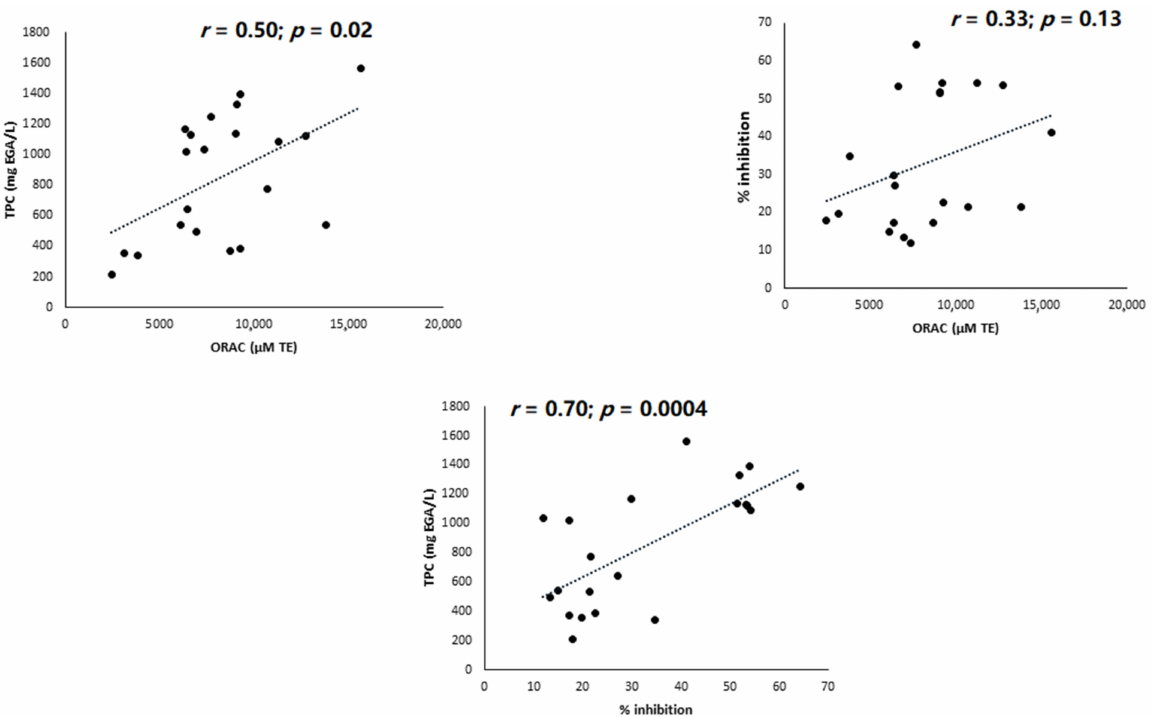
Figure 2. Graphic correlations between total polyphenol content (TPC), Oxygen Radical Antioxidant Capacity (ORAC) values, and % superoxide anion inhibition. EAG: equivalent gallic acid; TE: trolox equivalent. Table 2. Mean concentrations ( µ M), established for the whole set of juices, of phenolic compounds